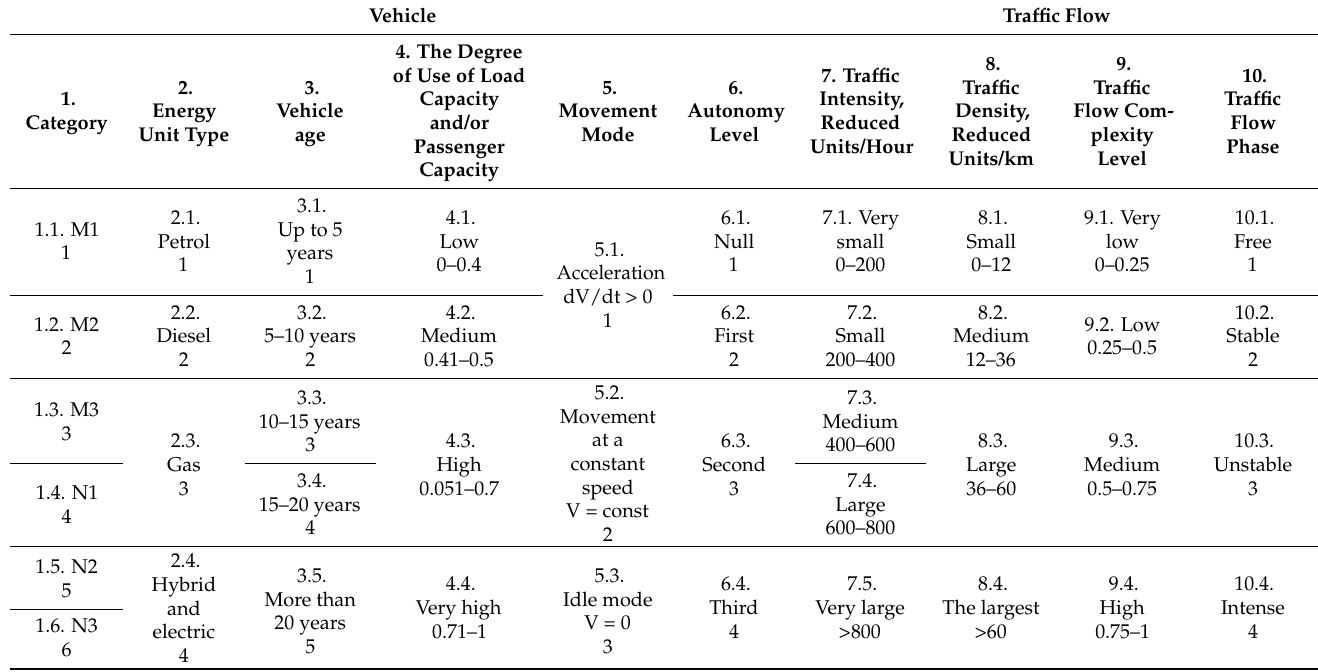
Table 1. Results of the analysis of the functional elements “Vehicle” and “Traffic flow”.